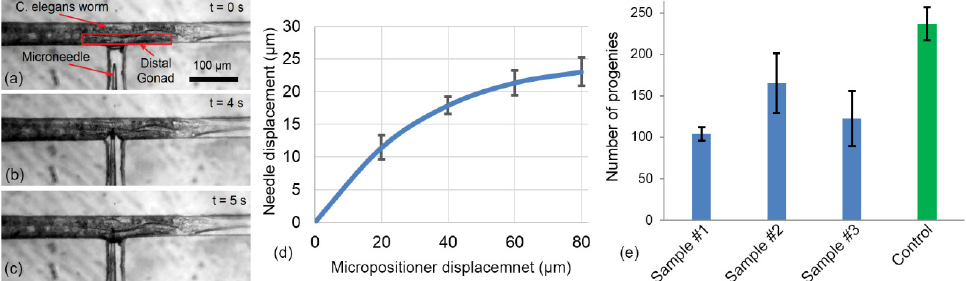
Figure 12. ( a – c ) image sequence of the needle insertion, ( a ) the microneedle was aligned with distal gonad of the worm, ( b ) the microneedle was moved and penetrated into the worm, ( c ) the microneedle was inserted into the gonad and suitable for the reagent delivery. ( d ) The characterization of the compliant mechanism. A known displacement has been applied to the micropositioner and measuring the movement of the microneedle was calculated using images of the tip of the microneedle. The experiment has been repeated for 8 times on one device. The minimum resolution of the micropositioner was 20 µ m. ( e ) Viability test of the worms after needle insertion. Worms (n = 5 for each plate) reproduction rate 72 h after needle insertion compared to not inserted control worms.